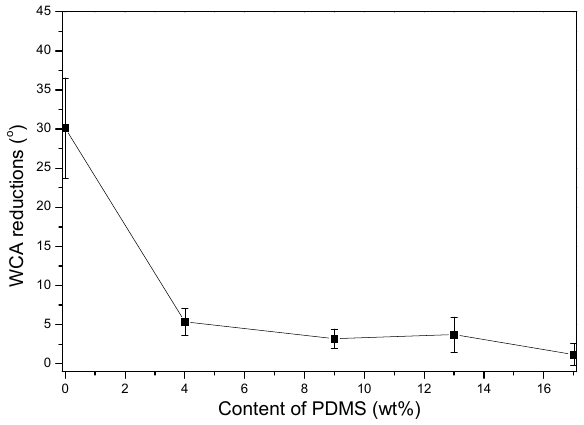
Figure 13. WCA reductions of the PU-Sis samples after immersion in seawater. Coatings 2018 , 8 , x FOR PEER REVIEW